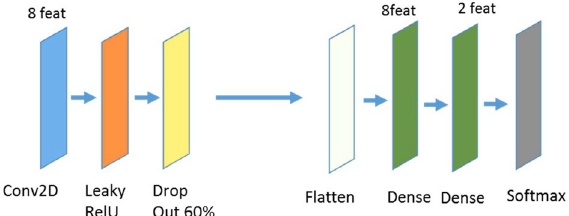
Fig. 2 Workflow of the CNN used in this study: The convolutional block consists of a convolutional layer followed by a LeakyReLU layer with alpha set to 0.2. The convolutional layer consists of 8 filters. The dropout percentage is set to 0.6. The first dense layer consists of 8, the second one of 2